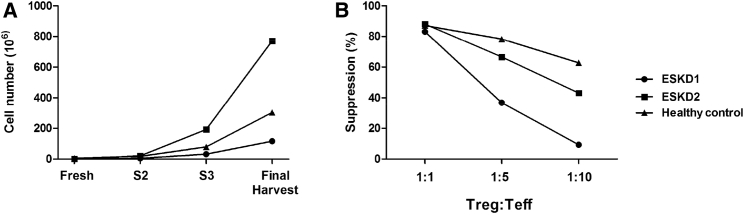
Expansion of Clinical Grade Tregs in the BRC GMP FacilityTregs isolated in accordance with GMP protocols from two end-stage kidney disease patients and a healthy control. (A) Comparable final harvest cell numbers were observed between ESKD1 (117 × 106), ESKD2 (770 × 106), and the healthy control (303 × 106). (B) Suppressive ability of Tregs was measured as a decrease of proliferation of effector T cells in the presence of different concentrations of Tregs (Treg:Teff 1:1, 1:5, and 1:10). Graph denotes a suppression assay, with expanded Tregs after the 36-day expansion.